Question: Draft a figure caption describing what is shown.
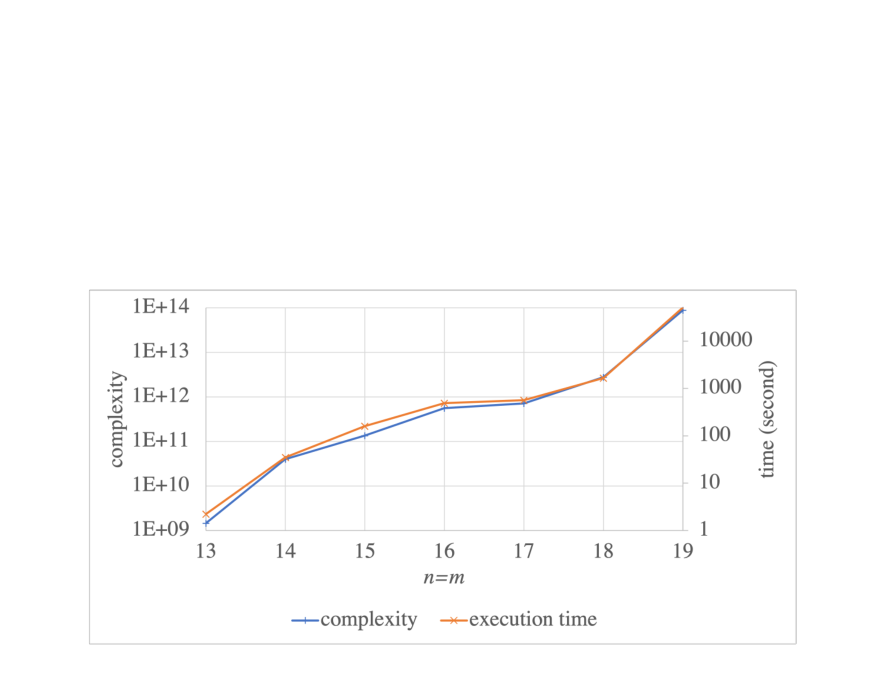
Answer: Comparison between the estimation of complexity by (4.7) and the execution time of the Linearize(1) step on an MQ system with n = m over F24.